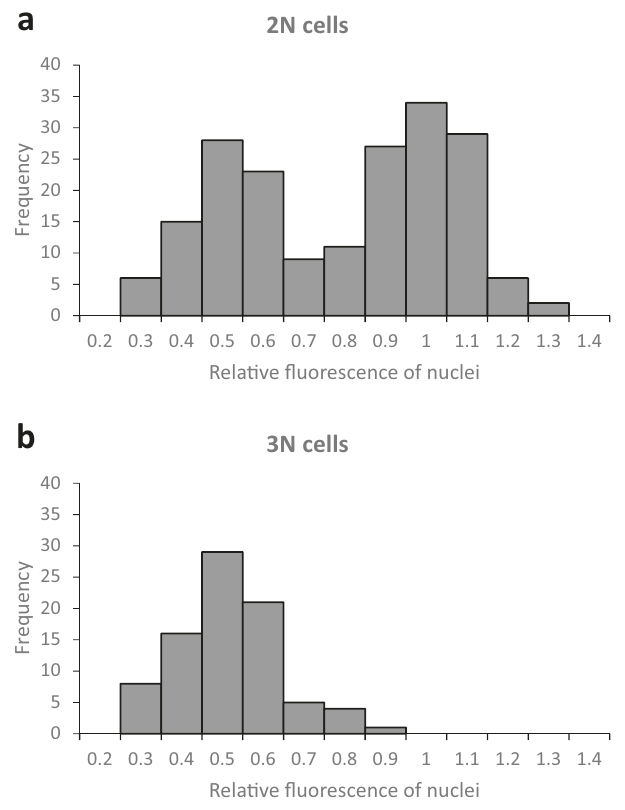
Fig. 5 Ratio of fl uorescence intensities of nuclei within individual 2N and 3N cells. The total fl uorescence intensity of each individual nucleus within a cell was measured and the ratio between nuclei in the same cell was determined. For 2N cells ( a , n = 190), the ratio of fl uorescence intensities of both nuclei in the same cell is shown; for 3N cells ( b , n = 42), the ratio of fl uorescence intensities of each of the two small nuclei was compared with that of the large nucleus. The fi gures on the x -axis are the upper bound of each bin; bin size